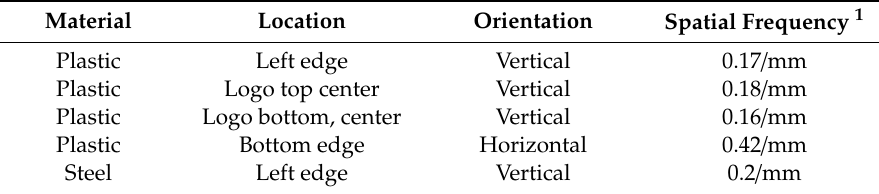
Table 2. MTF measurements from di ff erent locations from within the